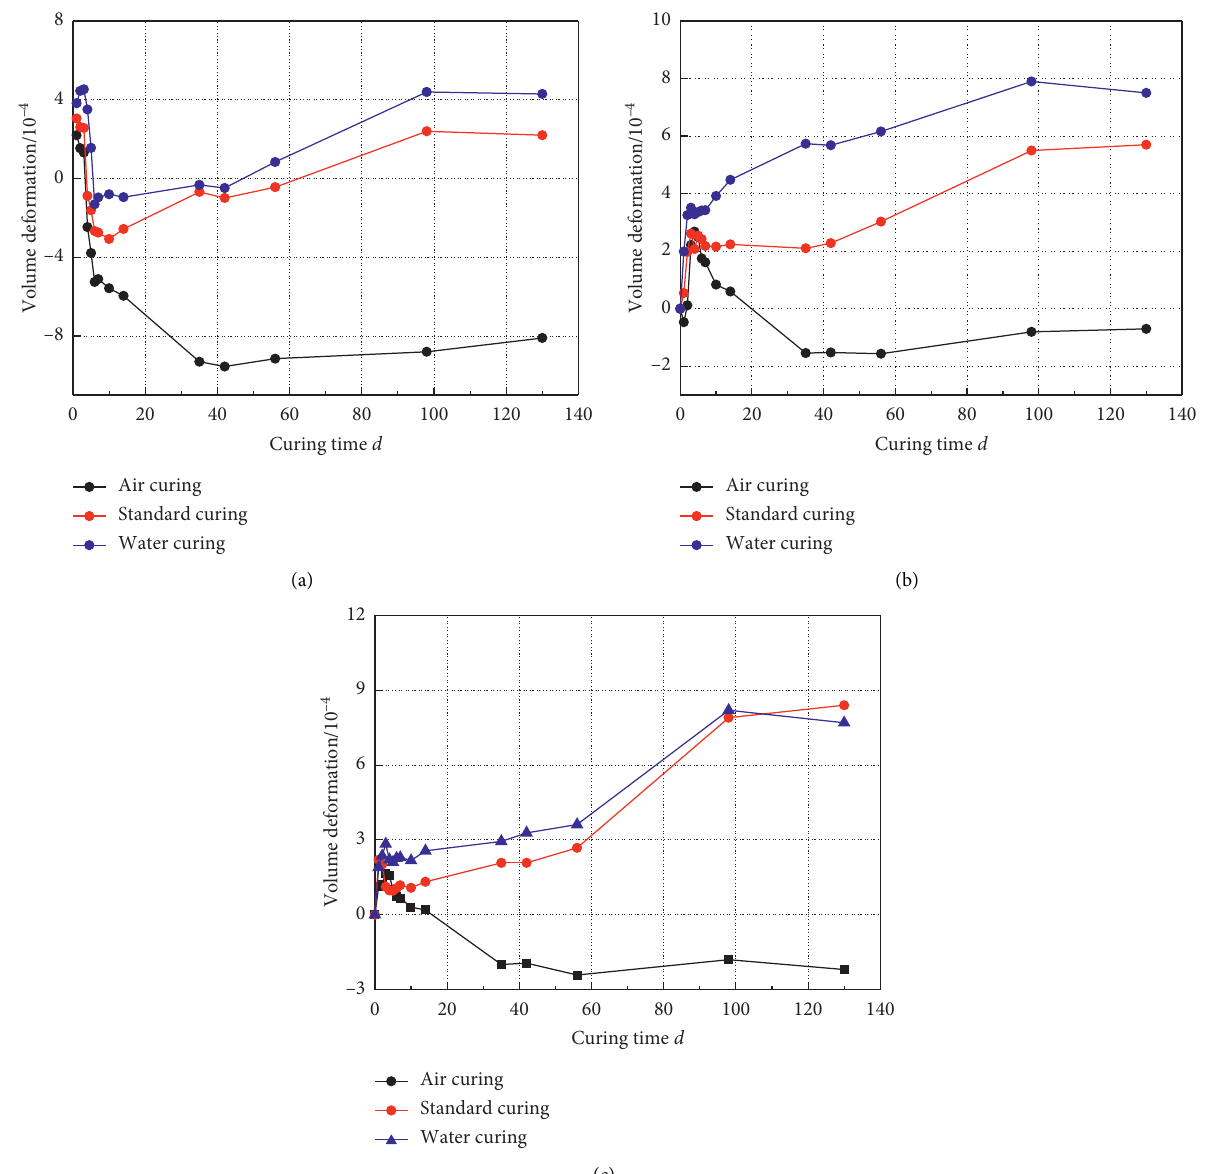
Figure 2: Volume deformation of MPC under various curing conditions. (a) M / P � 3:1, (b) M / P � 4:1, and (c) M / P �